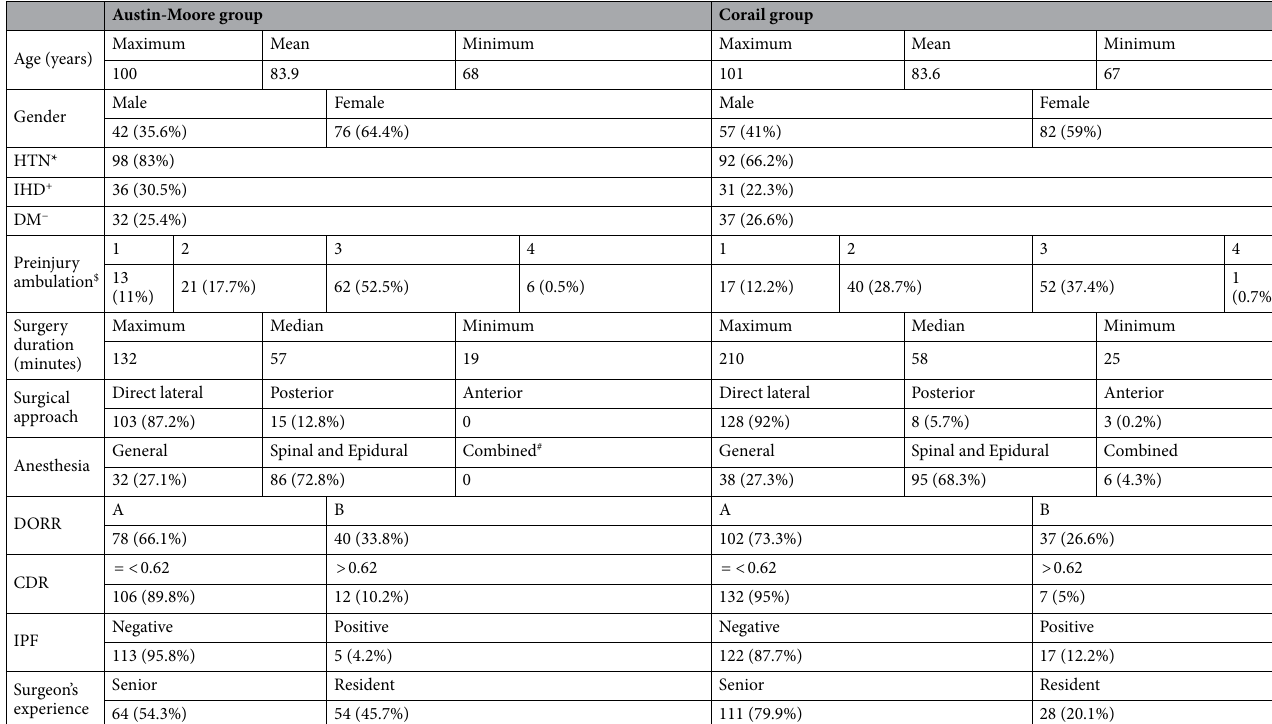
Table 1. Presents an overview of patient demographics and results. *HTN – Hypertension, + IHD –